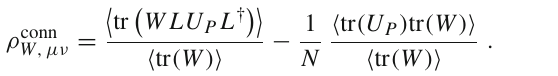
a static q ¯ q pair is the following connected correlator